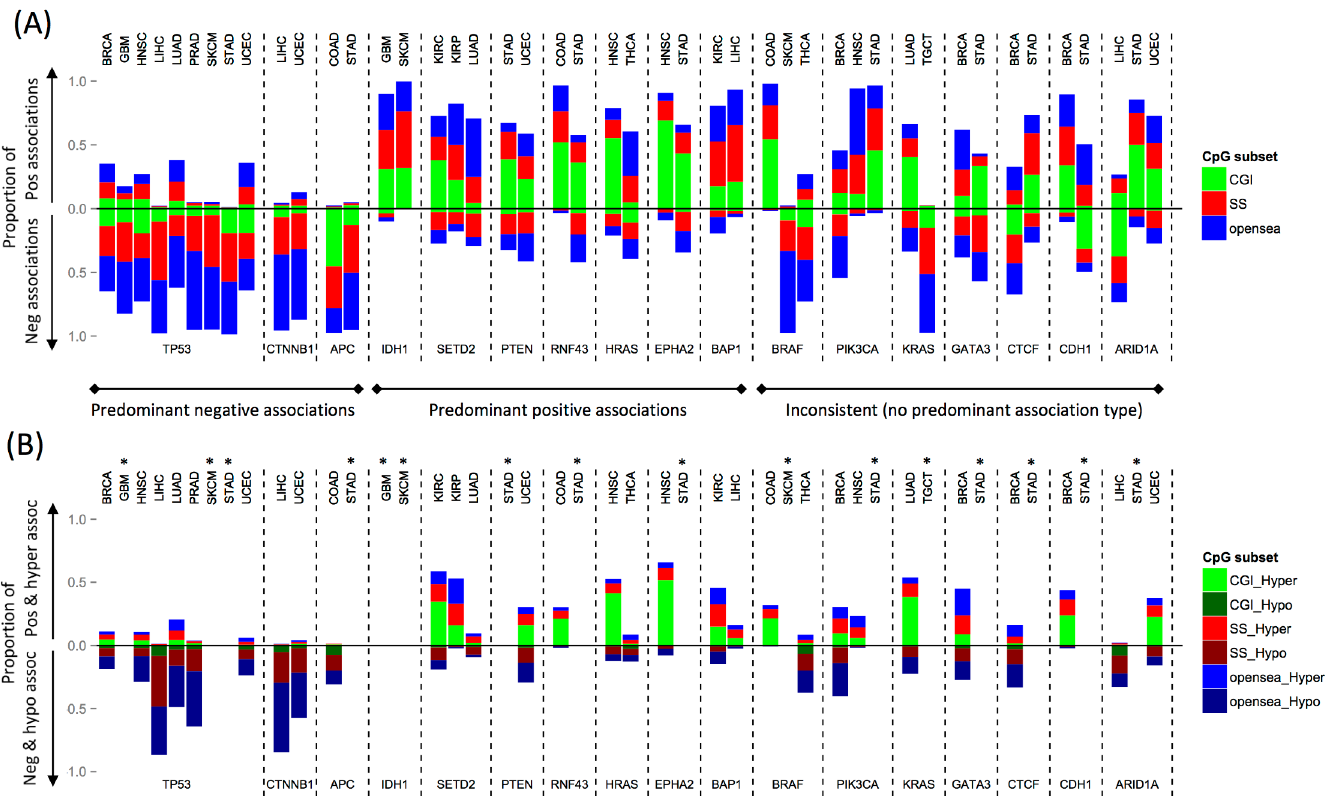
Fig 3. Proportion of positive and negative associations with methylation for 17 recurrently mutated driver genes. (A) Bar plots show the proportionof methylation probesfor each driver gene ( labelsat bottom ) and cancer type ( labelsat top ) displayingpositive and negative associations. Positive associationsare plotted above the horizontalline, negativeassociationsbelowthe horizontal line. Associations are further stratified by CpG subset: CpG islands (CGI), shores and shelves(SS), and open sea (regionsoutsideCGIs and SSs). Driver geneswere classifiedinto three groups based on the directionality of their predominant associations( negative , positive , inconsistent ). All genesshown were associated with more than 1,000 probes, in at least two cancer types. See Table 1 for cancer type abbreviations. (B) Plotted as in (A), using: (1) positivelyassociatedand hypermethylated probes and (2) negativelyassociatedand hypomethylated probes. * Hyper- or hypomethylated probes were not identifiedfor glioblastoma (GBM), stomach adenocarcinoma(STAD), skin cutaneousmelanoma(SKCM), and testicular germ cell tumor (TGCT) due to a lack of normal